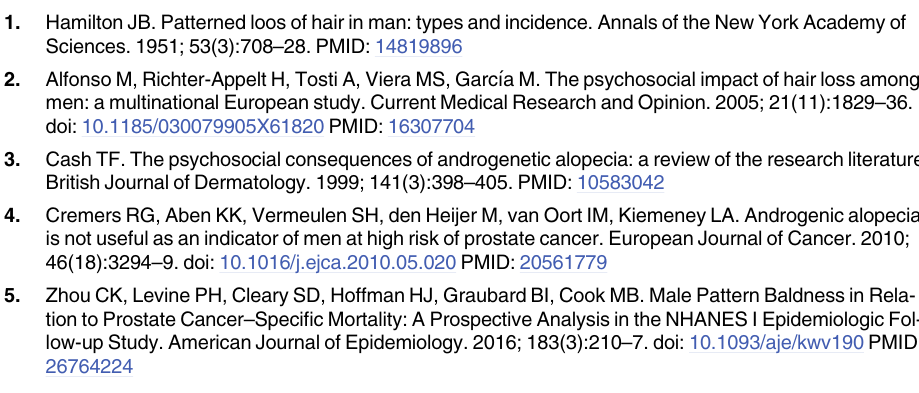
S1 Fig. Male pattern baldness QQ Plot for imputed GWAS of autosomal variants (p-values truncated at 1x10 -30 ). S2 Fig. Enrichment analysis for male pattern baldness using the 52 functional categories in 52,874 individuals. The enrichment statistic is the proportion of heritability found in each functional group divided by the proportion of SNPs in each group (Pr(h 2 )/Pr(SNPs)). Error bars are jackknife standard errors around the estimate of enrichment. The dashed line indi- cates no enrichment found when Pr(h 2 )/Pr(SNPs) = 1. FDR correction indicated significance at P = 0.011 indicated by asterisk S3 Fig. Enrichment analysis for male pattern baldness using the 10 cell specific functional The enrichment statistic is the proportion of heritability found in 52,874 individuals. In each functional group divided by the proportion of SNPs in each group (Pr(h 2 )/Pr(SNPs). Error bars are jackknife standard errors around the estimate of enrichment. The dashed line indicates no enrichment found when Pr(h 2 )/Pr(SNPs) = 1. FDR correction indicated signifi- cance at P = 0.037 indicated by